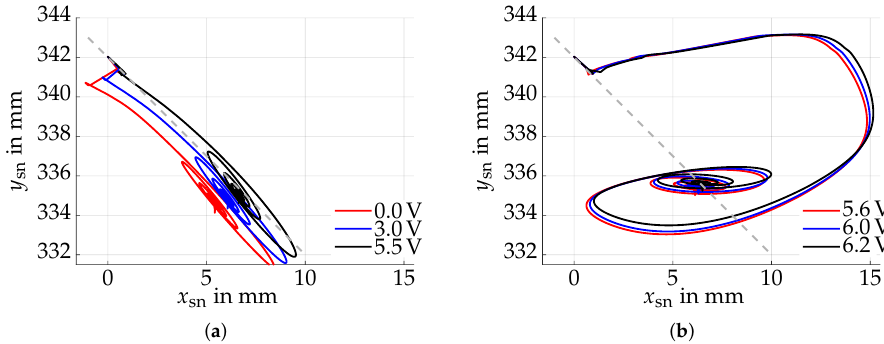
Figure 8. Effect of the voltage offset v off for beam 1 for an initial deflection of α = − 20°. The goal is to achieve a resulting rotation direction of − 45° (dashed line). ( a ) A voltage offset up to 5.5V reduces the rotation direction error with small oscillation in its perpendicular direction. ( b ) A further increase of the voltage up to approximately 6.2V leads to a change in the overall behavior, including larger oscillations in undesired directions, but achieves higher accuracy of the final